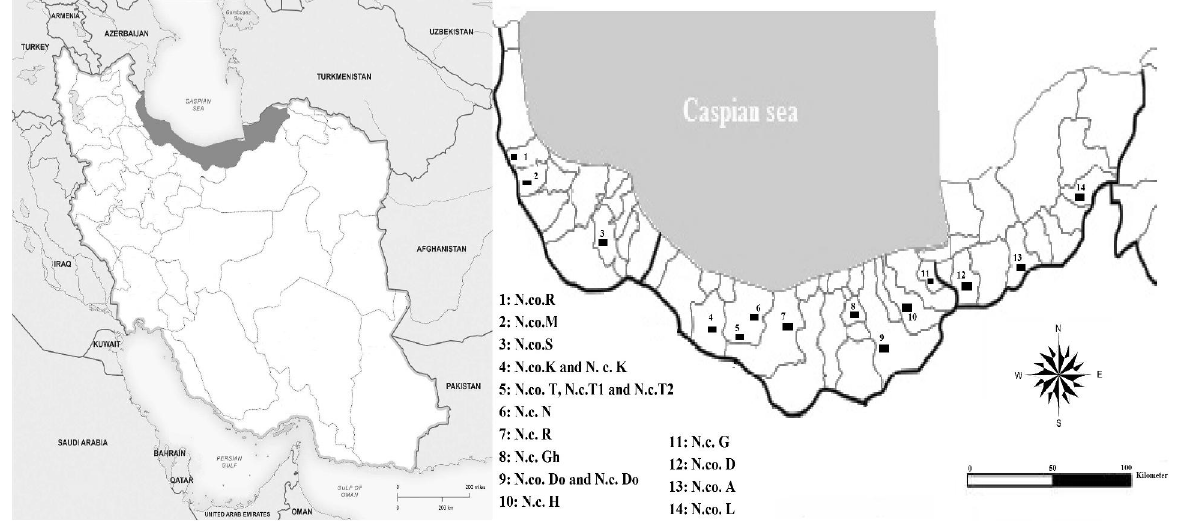
Fig. 1. Localities of populations of N. complanata and N. crispa in this study: The numbers refer to populations and species quitted in Table